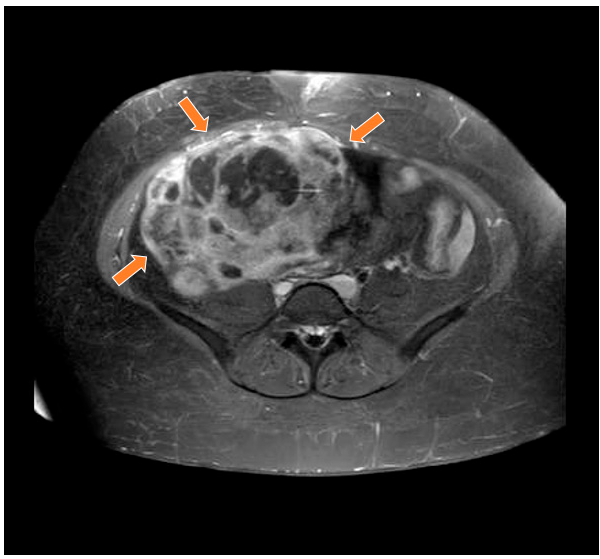
Figure 2. Magnetic resonance study in T1 weighted sequence post gadolinium showing a heterogeneous mass in the pelvic region (orange arrows).